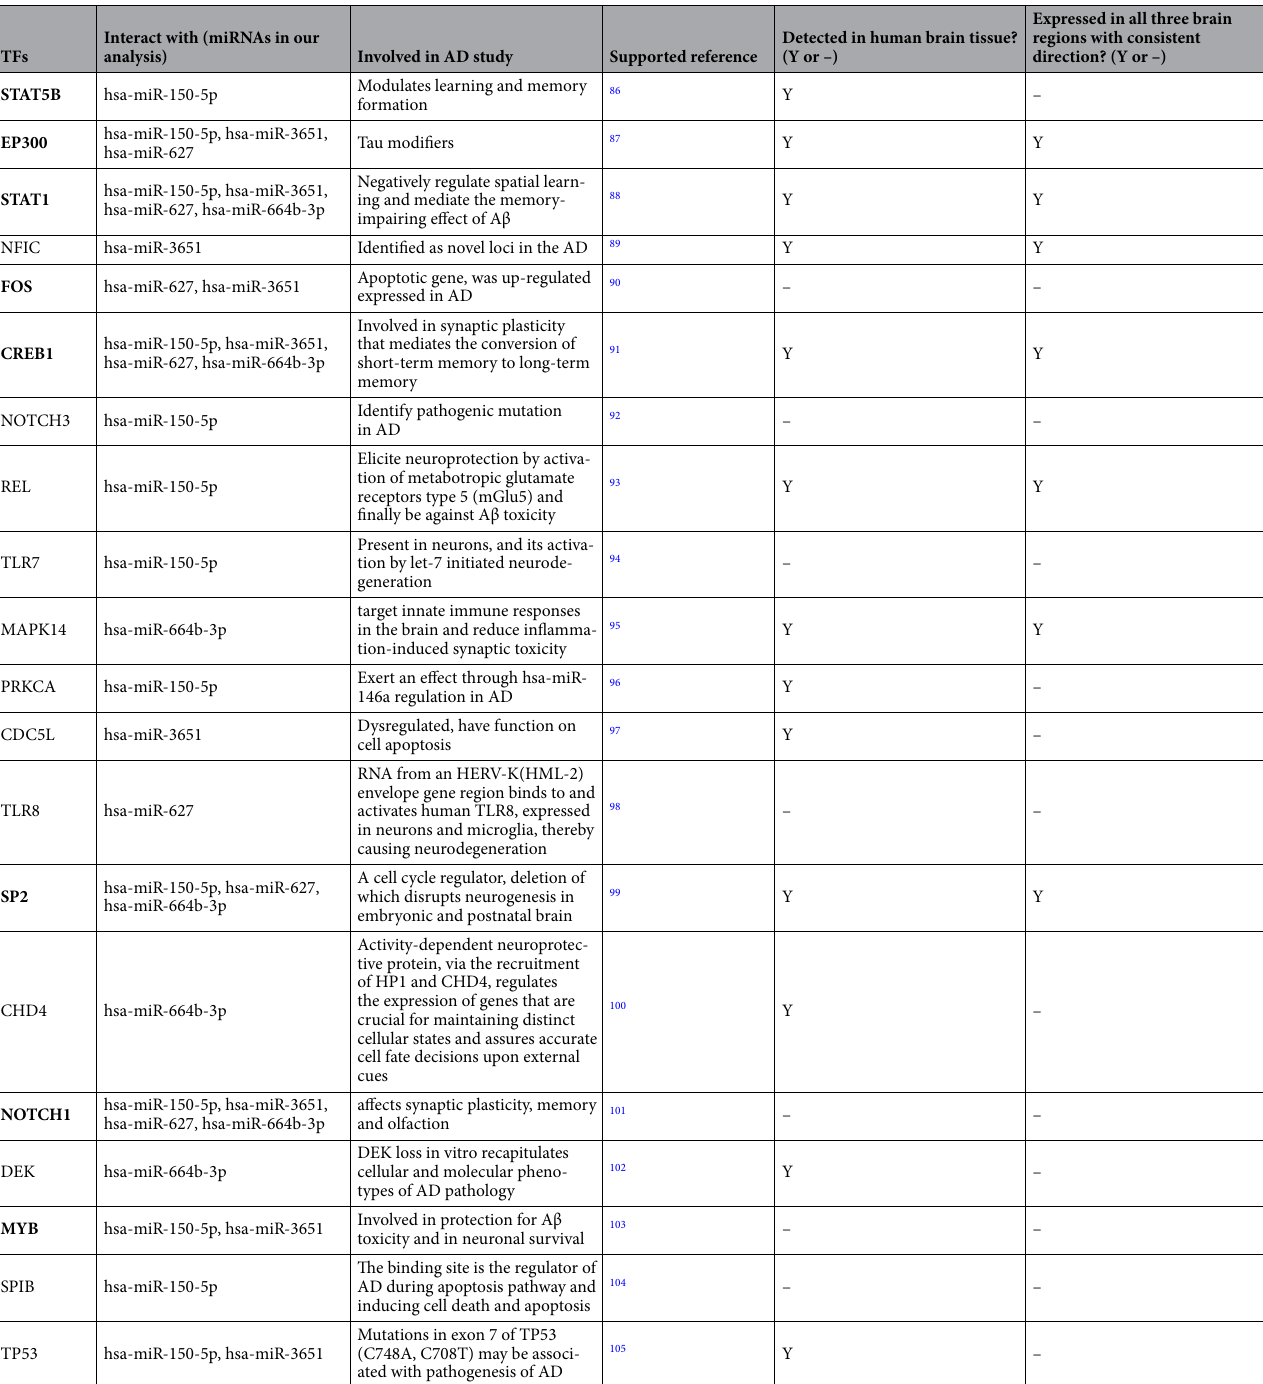
Table 2. The potentially AD-related TFs among gene targets of lead exposure associated miRNAs based on TransmiR v2 and TRRUST v2 databases. The bold TFs are hubs in the network (Fig. 6), “Y” means yes, “–” means no. The supported reference was the most relevant